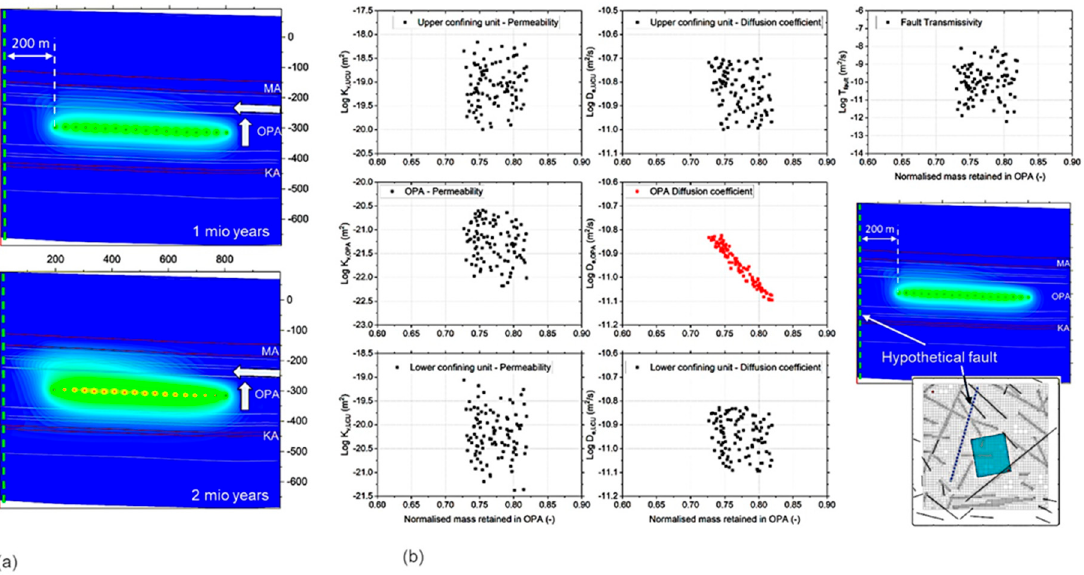
Figure 17. Assessment of minimum distance from fault zones: ( a ) tracer mass fractions under a conservatively high lateral gradient in the upper confining units; ( b ) correlations between retained mass in host rock and perturbed parameters. Red symbols plotted in ( b ) indicate strong